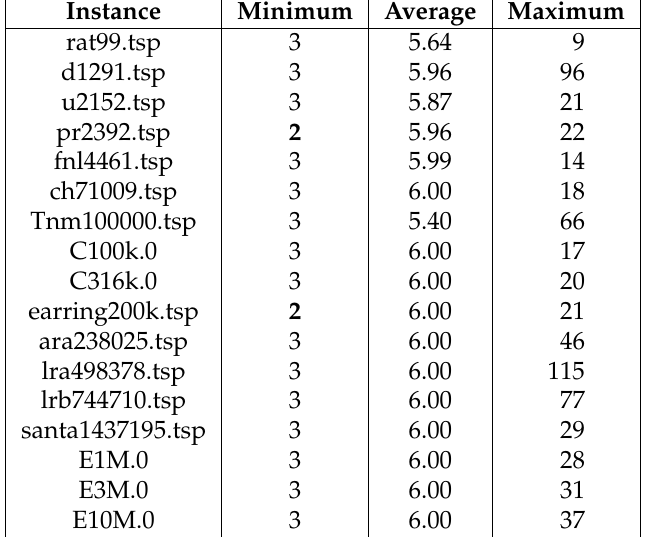
Table 1. Number of candidates per point determined via Delaunay